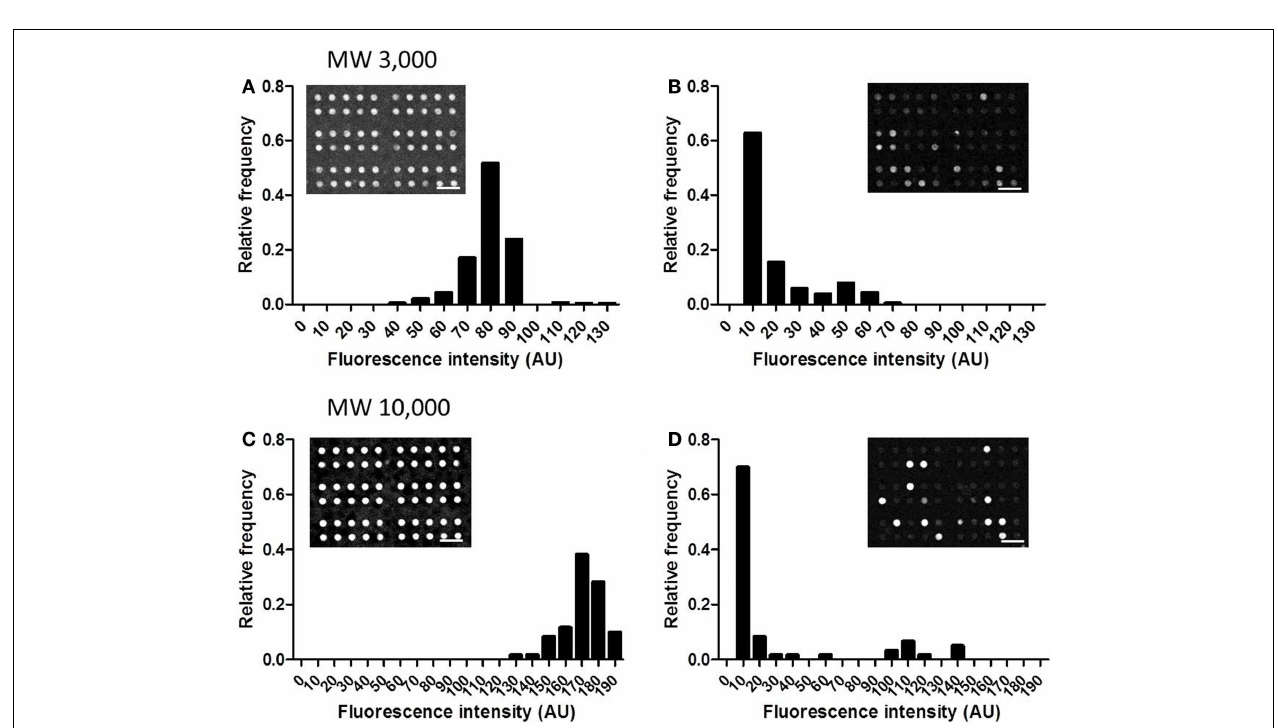
FIGURE 5 | Distribution of the intensity from fluorescent dextran retained in microchambers . (A) MW 3,000, before washing. (B) MW 3,000, after washing. (C) MW 10,000, before washing. (D) MW 10,000, after washing. All scale bars in micrographs represent 50 µ m.